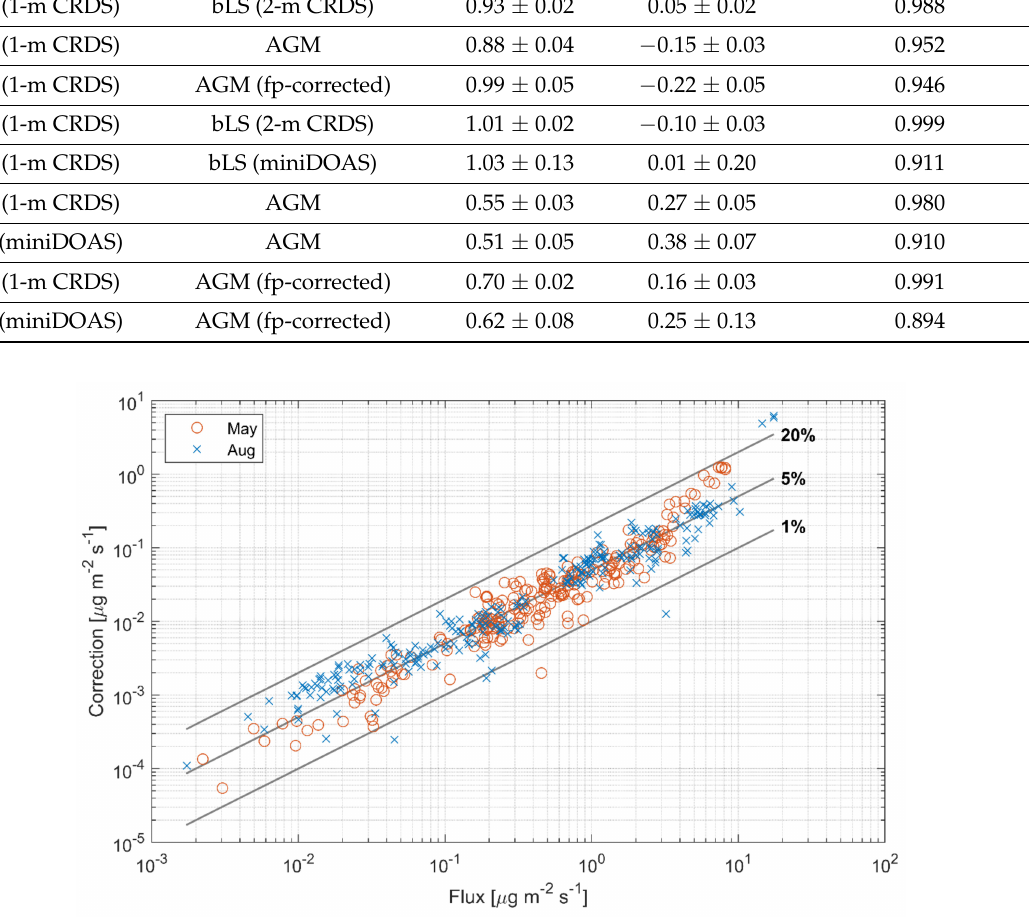
Table 4. Regression coefficients for Deming regression between the compared methods. Compared Methods for Regression